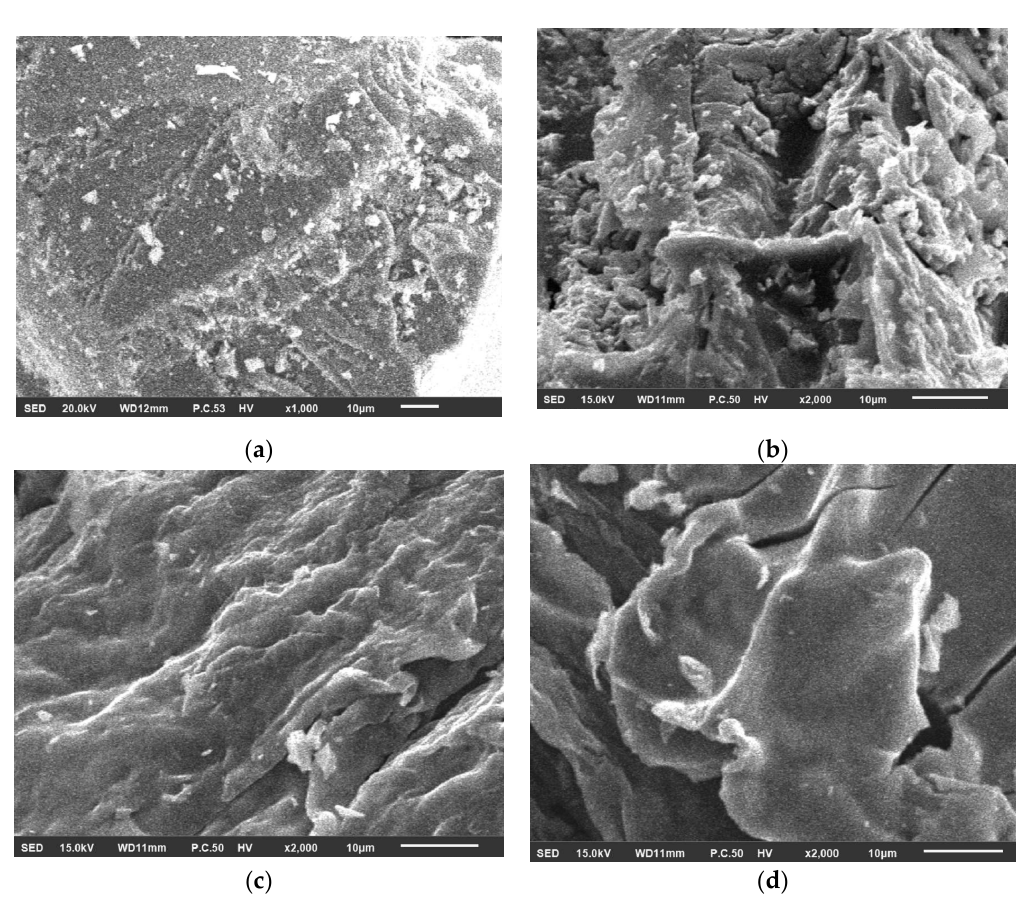
Figure 2. Morphology of N,S-TiO 2 ( a ), RSB/N,S-TiO 2 ( b ), ASB/N,S-TiO 2 ( c ), and CSB/N,S-TiO 2 ( d ).